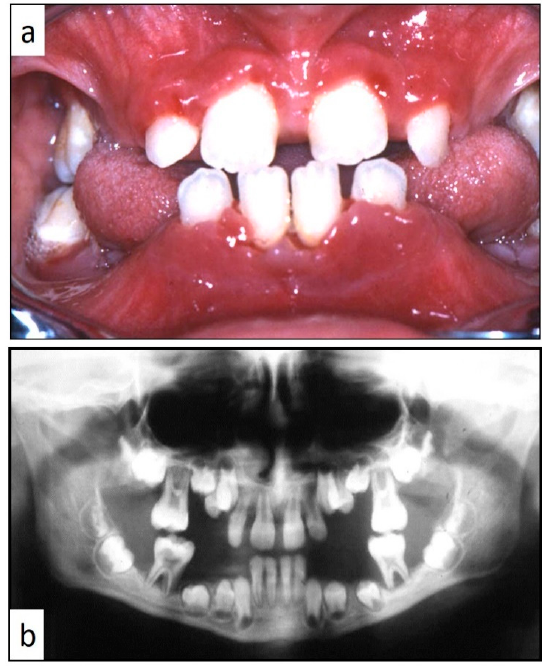
Figure 4. ( a , b ): Involvement of the entire periodontium, gingiva ( a ) and alveolar bone ( b ), of the